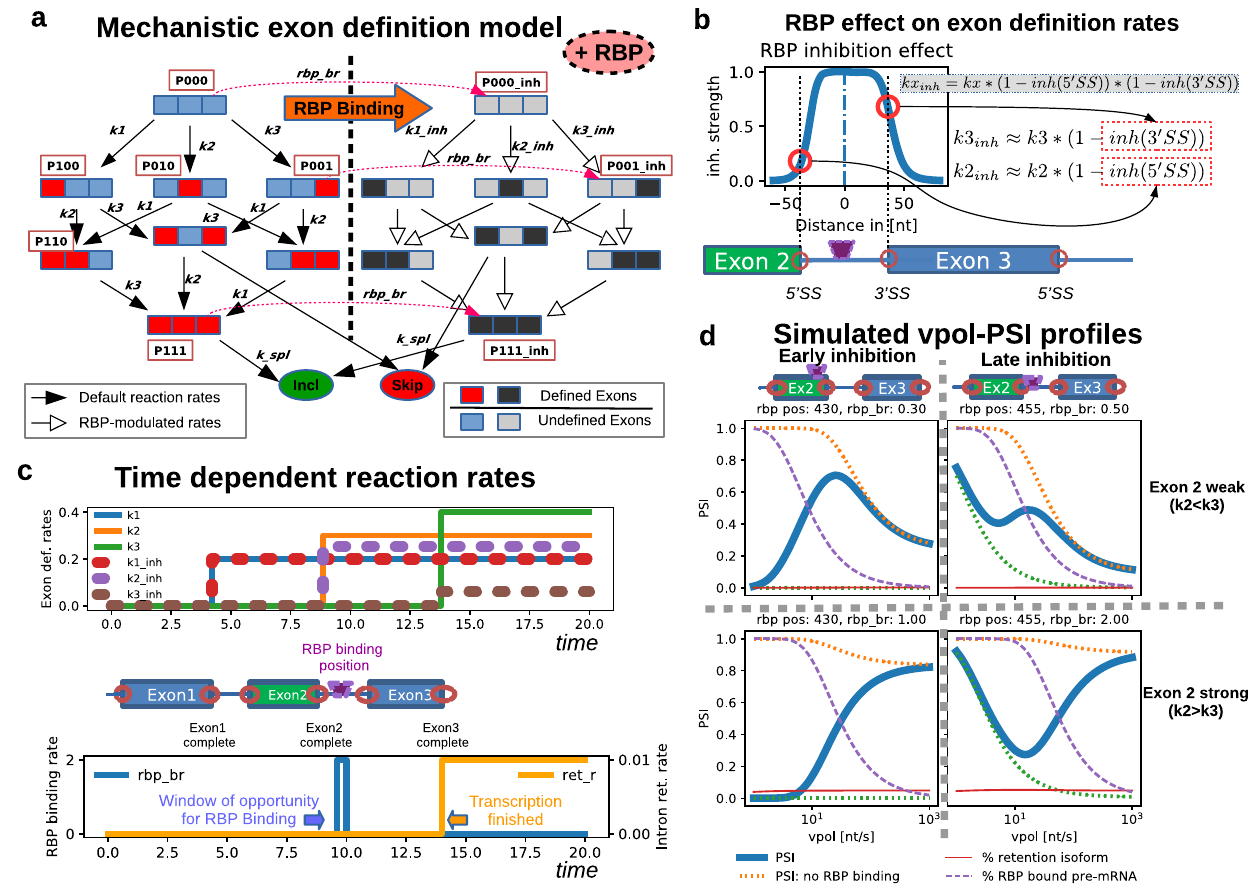
Fig. 3 Mechanistic modeling of spliceosome binding and exon modulation by RBPs. a Exon de fi nition model of co-transcriptional splicing. In the unbound pre-mRNA (P000) each exon can be cooperatively bound by the spliceosome and this is modeled using lumped and irreversible exon de fi nition reactions (rate constants k 1 -k 3 ). De fi nition of the 1 st , 2 nd and 3 rd exon switch P000 to the states P100, P010, P001, respectively. Spliceosome binding affects splicing outcomes (modeled by the splicing reaction k spl ), as the states P101 (exon 2 unde fi ned) and P111 (exon 2 de fi ned) give rise to skipping and inclusion, respectively, whereas no splicing (but intron retention) is possible otherwise. The inhibitory RBP irreversibly binds to unspliced pre-mRNA states (transition from left to right subnetwork; e.g., P000 → P000_inh), affects spliceosome binding (reduced rates k1_inh-k3_inh), but splicing rates remain unchanged (k_spl). See also panels b and c , and Supplemental Material for details. b Local effects of RBP binding on exon de fi nition rates (k 1 -k 3 ). Not all three exon de fi nition rates (k 1 -k 3 ) are reduced by RBP binding, but only those of exons located nearby the RBP binding site (indicated by magenta pictogram and vertical dashed line at x = 0). Inhibition is modeled by a bell-shaped inhibition function (kx inh ), in which the RBP effects on k 1 -k 3 decay within + / − 50 bp around the binding site. c Implementation of co-transcriptional splicing using time-dependent reaction rates. Shown are the reaction rates as a function of time after transcript initiation, with step-like increases or decreases corresponding to time delays. The schematic representation of the three-exon minigene indicates the correspondence of time delays and position of elongating RNA polymerase within the gene. Each exon can be de fi ned immediately after its transcription is complete (top), RBP binding occurs in a short time window after elongation across the RBP binding site and retention is possible only after transcription is fi nished. d Simulated PSI-vpol pro fi les for RBP binding within exon 2 (left) or in the downstream fl anking intron (right) using the local inhibition pro fi le depicted in B. Two simulations were performed for each RBP localization, in which either exon 2 is less well recognized than exon 3 (k2 < k3, top), or vice versa (k2 > k3, bottom). The PSI pro fi les (thick solid lines) can be considered as weighted sum of two limiting cases, a model without RBP-mediated inhibition (green dashed lines) and one in which the RBP binds with high ef fi ciency to ~100% of the transcripts (orange dashed lines). At low and high polymerase velocities, the PSI is approximated by strong and no RBP binding, respectively, as slow elongation extends the temporal window of opportunity for polymerase- mediated RBP-recruitment. The fraction of RBP-bound to the pre-mRNA in the full model (solid line) is shown as a dashed magenta line. The abundance of the retention isoform is shown as solid red motif. The spatial range of RBP effects on spliceosomes which we implemented in the model is depicted in Fig. 3b. We assumed a bell-shaped inhibition pro fi le, in which the RBP effects on k1-k3 decay within ~100 bp around the binding site, as previous (Fig. 3c; Supplementary Table 3). For RBP binding, we again experimental literature has shown a substantial decay in a assumed RNA polymerase-dependent recruitment 55 , and there- protein ’ s effect when a protein ’ s binding site is shifted from 70 to 140 or 200 bp from the splice site 57,58 . fore modeled RBP binding to be restricted to a short window- of-opportunity, re fl ecting the phase when the elongating Co-transcriptional spliceosome binding and splicing were enzyme pass the RBP motif (Fig. 3c, bottom). Since most considered in the model by assuming that an exon can only be